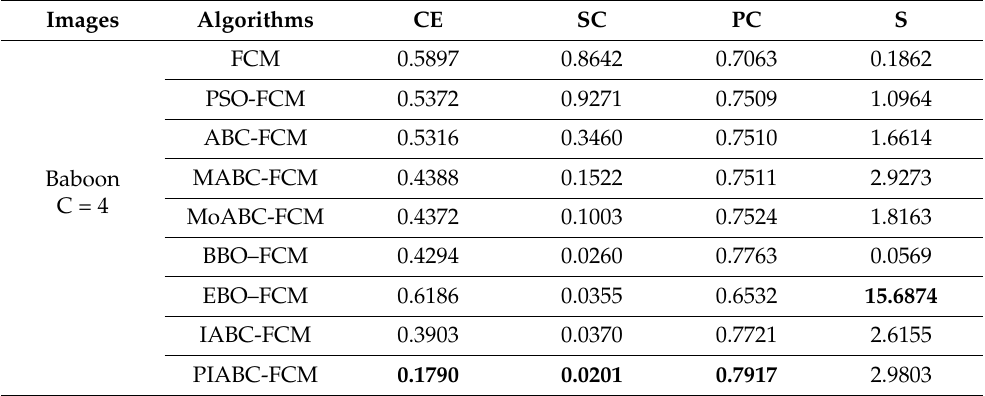
Table 3. Outcomes of PIABC-FCM and other clustering algorithms on the baboon image. Images